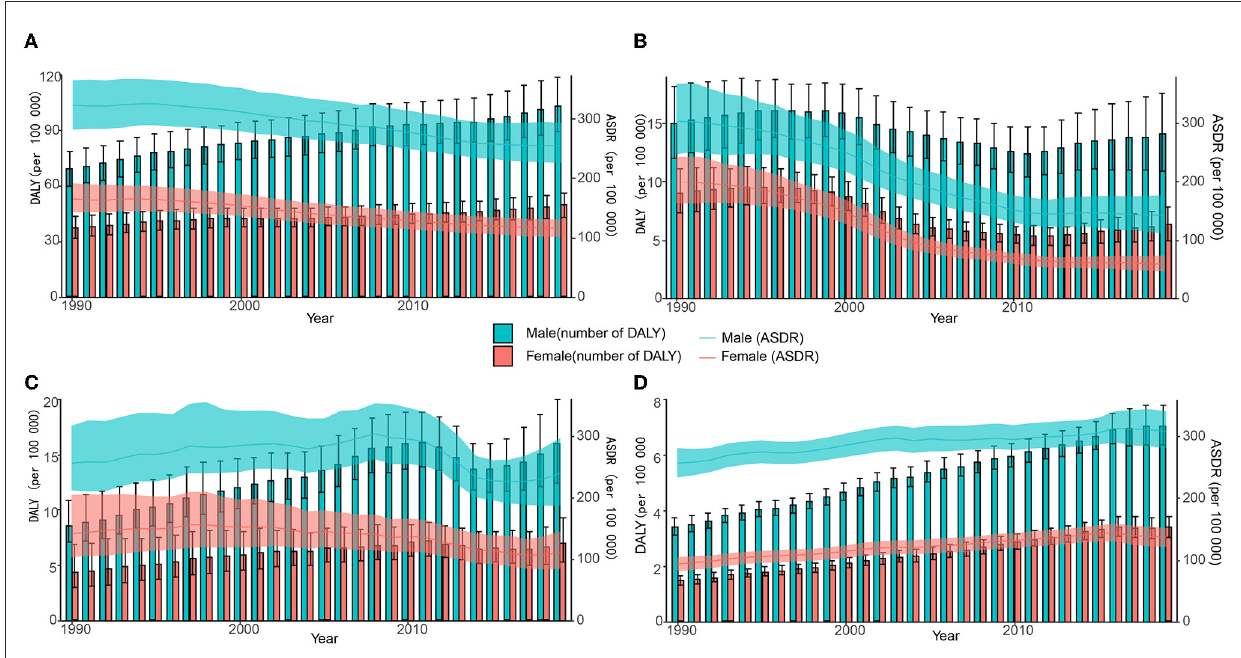
FIGURE3 Number and age-standardized rate of DALY with 95% uncertainty intervals (UIs) in different regions, 1990–2019. (A) Global; (B) China; (C) India; (D) the United States.